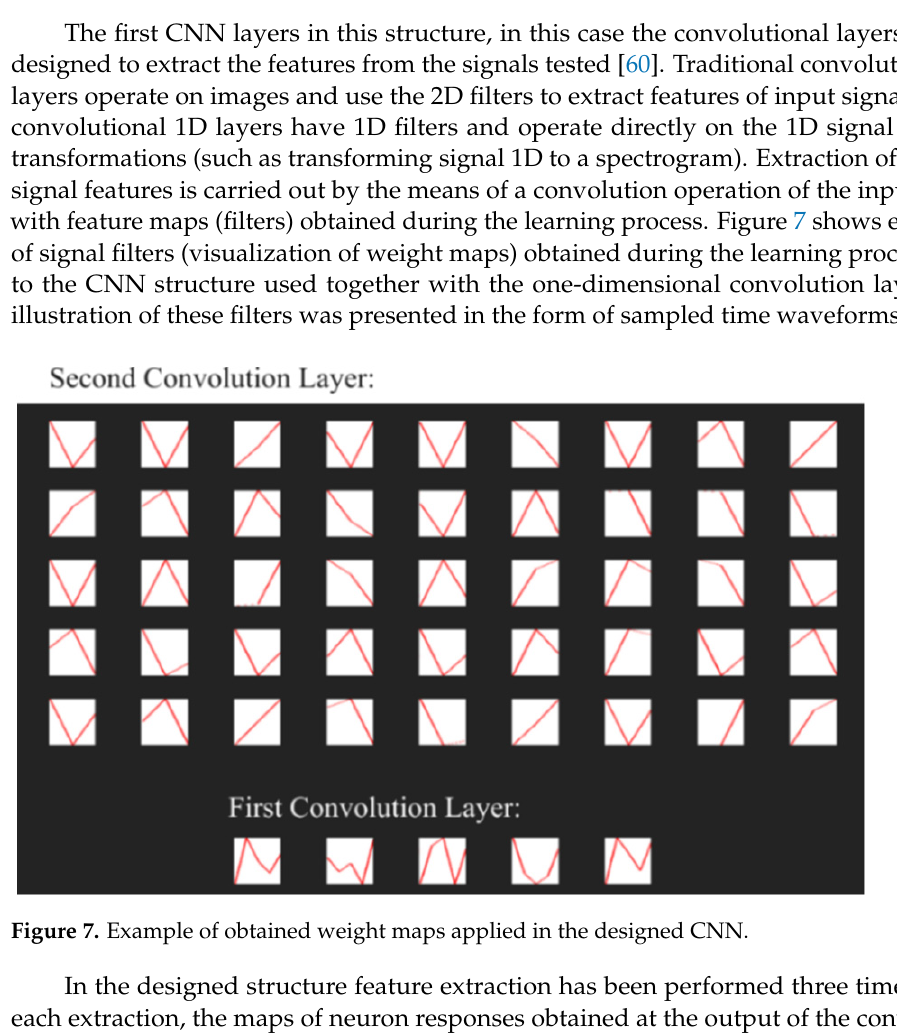
Table 3. Detailed structure of designed CNN for separate signals recognition depending on the ex- amined parameters (PRI, PD, TW).